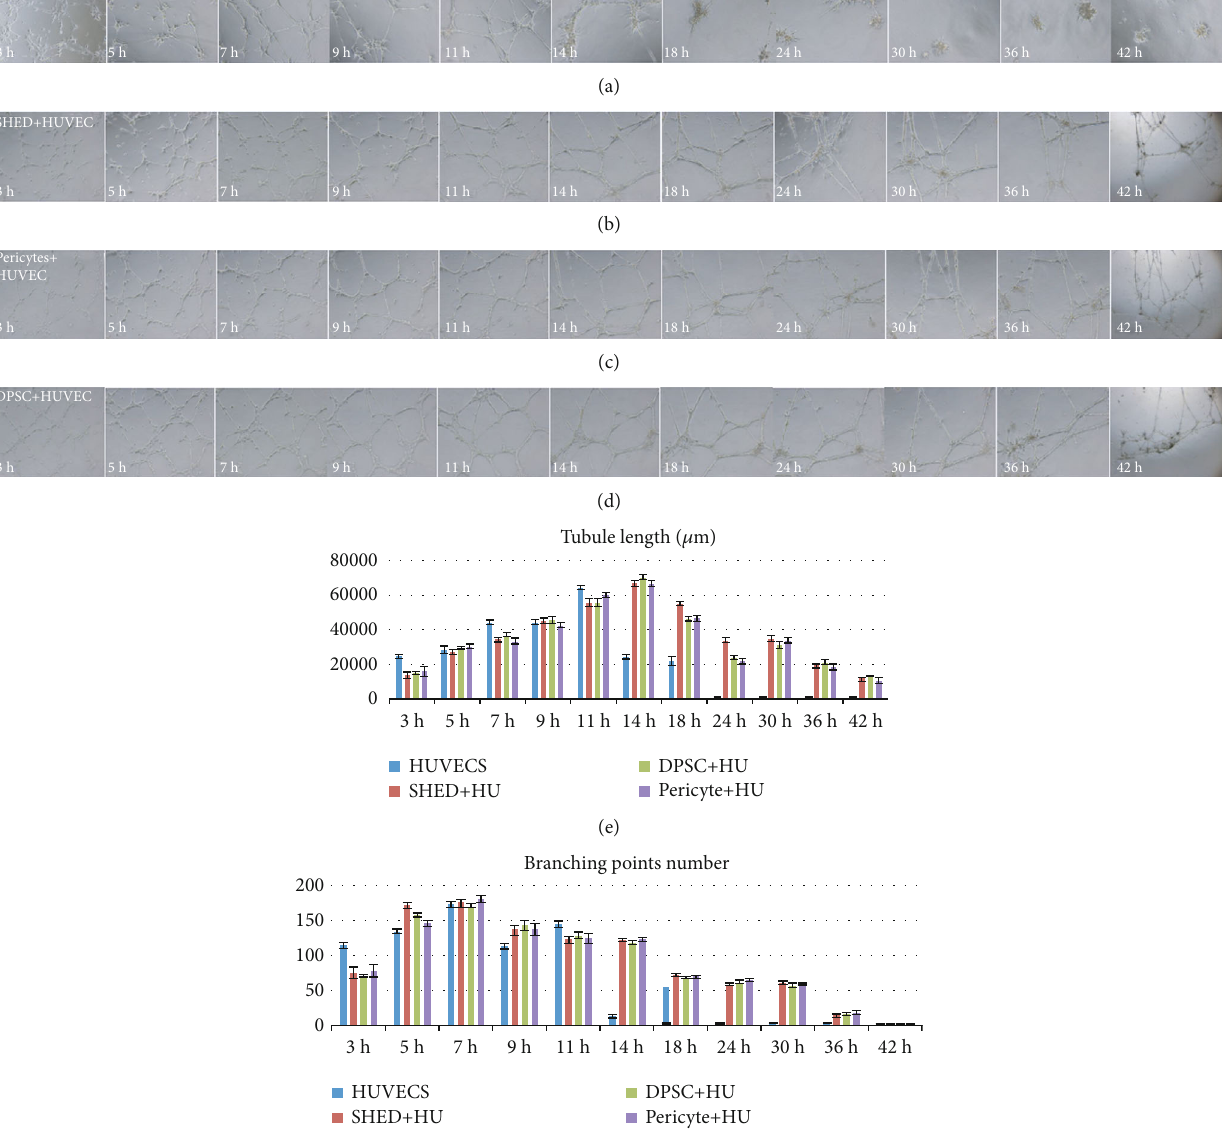
Figure 3: The vessel-like structure formation of endothelial cells (ECs) in coculture. (a) Human umbilical vein endothelial cell (HUVEC) alone. (b) Postnatal human dental pulp stem cell (DPSC)+HUVEC (1 : 1). (c) Stem cell from human exfoliated deciduous teeth(SHED)+HUVEC (1 :1) were cocultured on Matrigel. (e) Tubule length. (f) Branching point